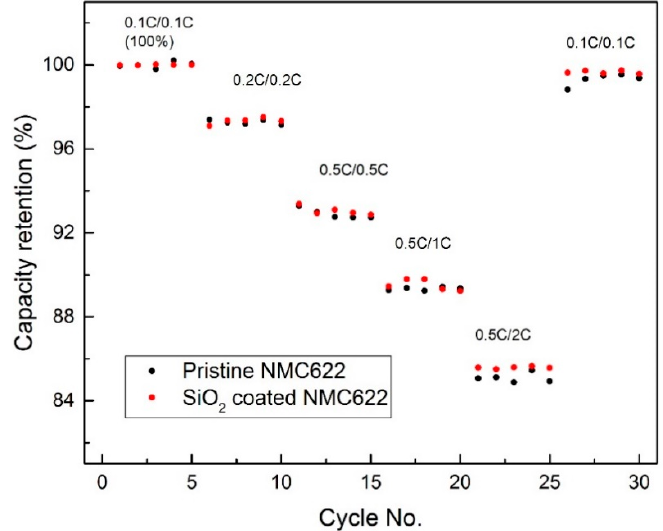
Figure 5. Comparison of rate capability between pristine and SiO 2 -coated NMC622.